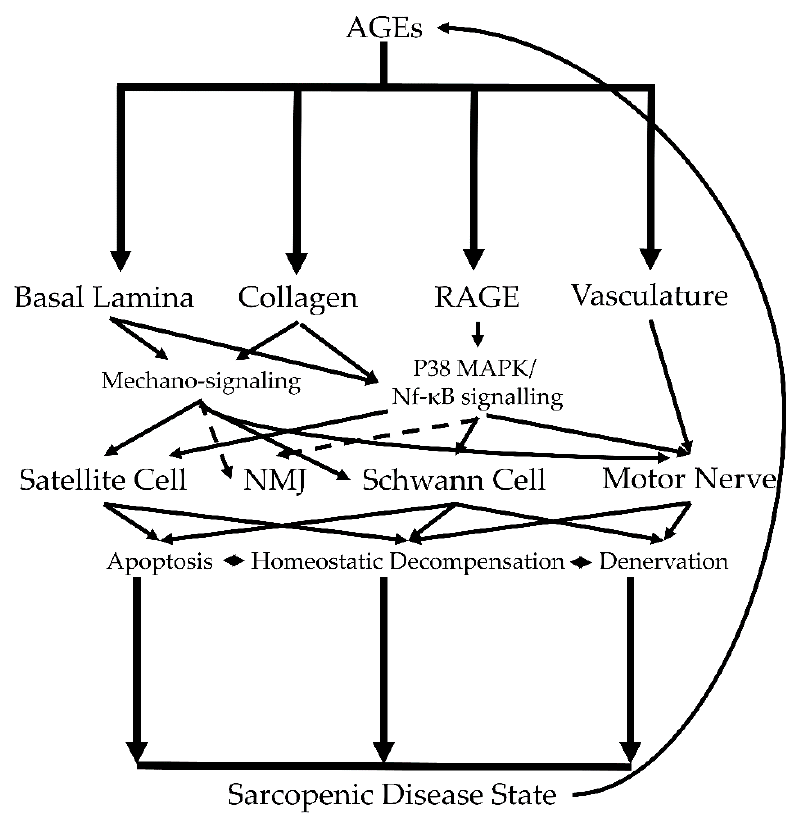
Figure 3. AGEs support a sarcopenic disease state in muscle by altering the basal lamina, collagen, RAGE signaling, and vasculature. These AGE-dependent changes accumulate and result in deleterious effects to satellite cells, NMJs, Schwann cells, and the motor nerve that culminate in sarcopenia. Known mechanisms are indicated by solid arrows while proposed mechanisms (future directions) are indicated with dashed arrows.